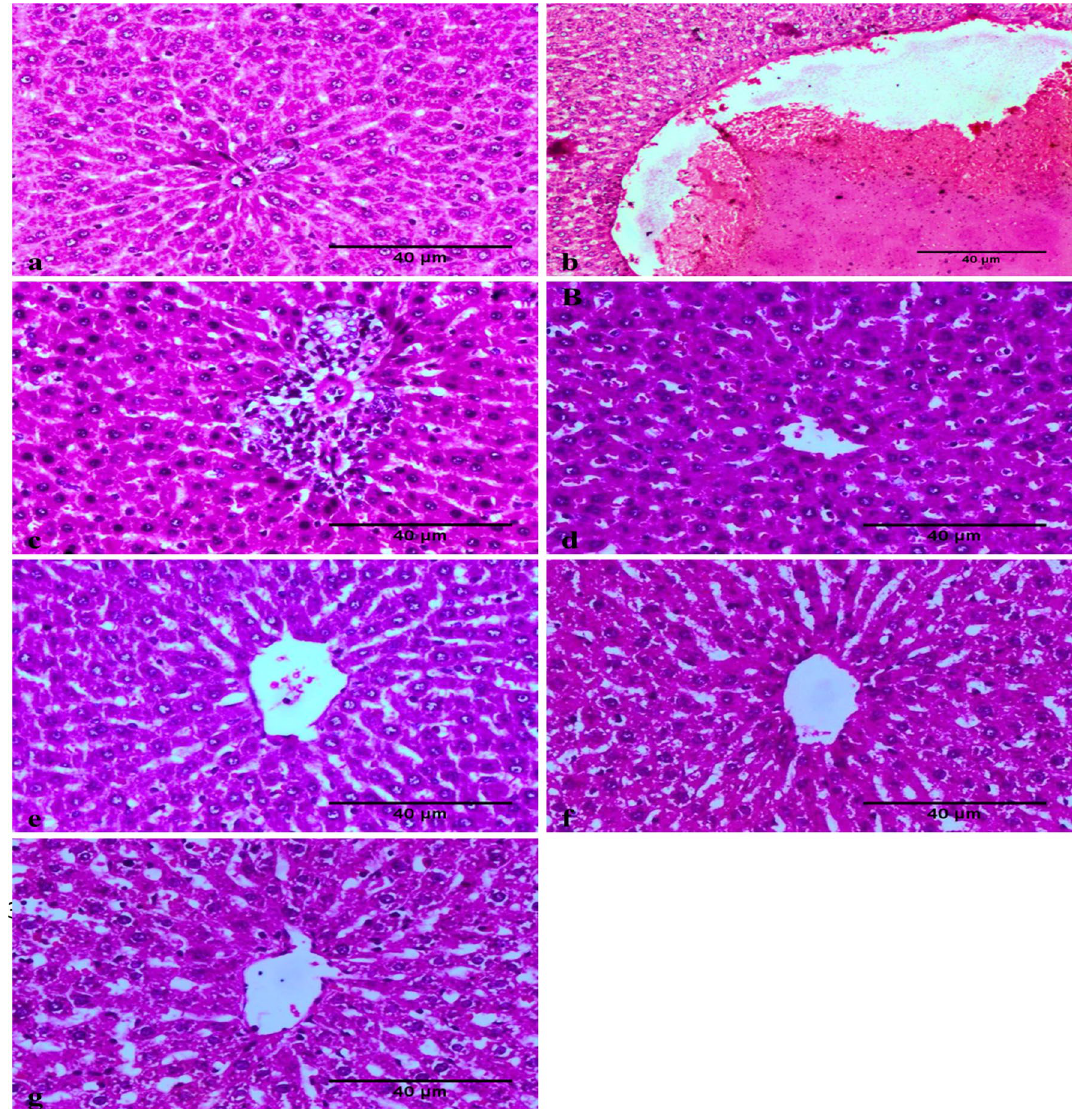
Figure 7. Photomicrograph showing the absence of histopathological changes in the of liver of negative control rats ( a ). In the benzo[a]pyrene (B[a]P)-treated group, disorganization of the hepatocytes and vascular dilation, congestion, and early non-occluding thrombus formation associated with hyalinization and thickening of blood vessel wall were observed ( b ). Degenerative changes in hepatocytes associated with leucocytic cell infiltration ( c ). A normal hepatic tissue was observed in a male rat exposed to zinc oxide nanoparticles (ZnO NPs) and B[a]P ( d and e ). A normal hepatic histology was observed in male rats treated with ZnO NPs (positive control groups) (scale bar: 40 μm) ( f and g